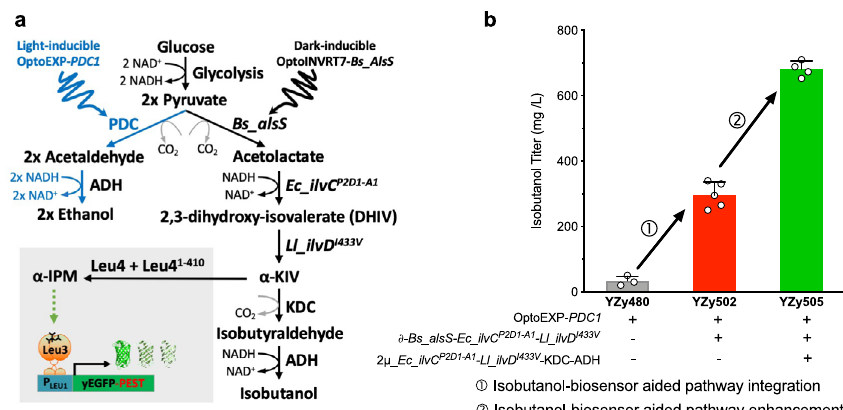
Fig. 6 Biosensor-assisted engineering of optogenetically controlled strains for cytosolic isobutanol production. a Schematic of the dark-inducible cytosolic isobutanol pathway (with Bs_alsS controlled by OptoINVRT7 ) and light-inducible PDC1 (controlled by OptoEXP ) in a triple pdc Δ strain containing the isobutanol con fi guration of the biosensor. b Isobutanol production of optogenetically regulated strains, including a basal strain containing only light- inducible PDC1 (YZy480, gray); a strain also containing the dark-inducible upstream cytosolic pathway ( Bs_alsS, Ec_ilvC P2D1-A1 , and Ll_ilvD I433V ) integrated in δ -sites (YZy502, red); and a strain containing additional enzymes from the cytosolic isobutanol pathway ( Ec_ilvC P2D1-A1 , Ll_ilvD I433V , KDC, and ADH) introduced in a 2 µ plasmid (YZy505, green). Isobutanol production was measured after 48 h fermentations in media containing 2% glucose. Strains YZy502 and YZy505 where each isolated after two rounds of FACS. All data are shown as mean values. Open circles represent individual data points. Error bars represent the standard deviation of at least three biological replicates. Source data are provided as a Source Data fi